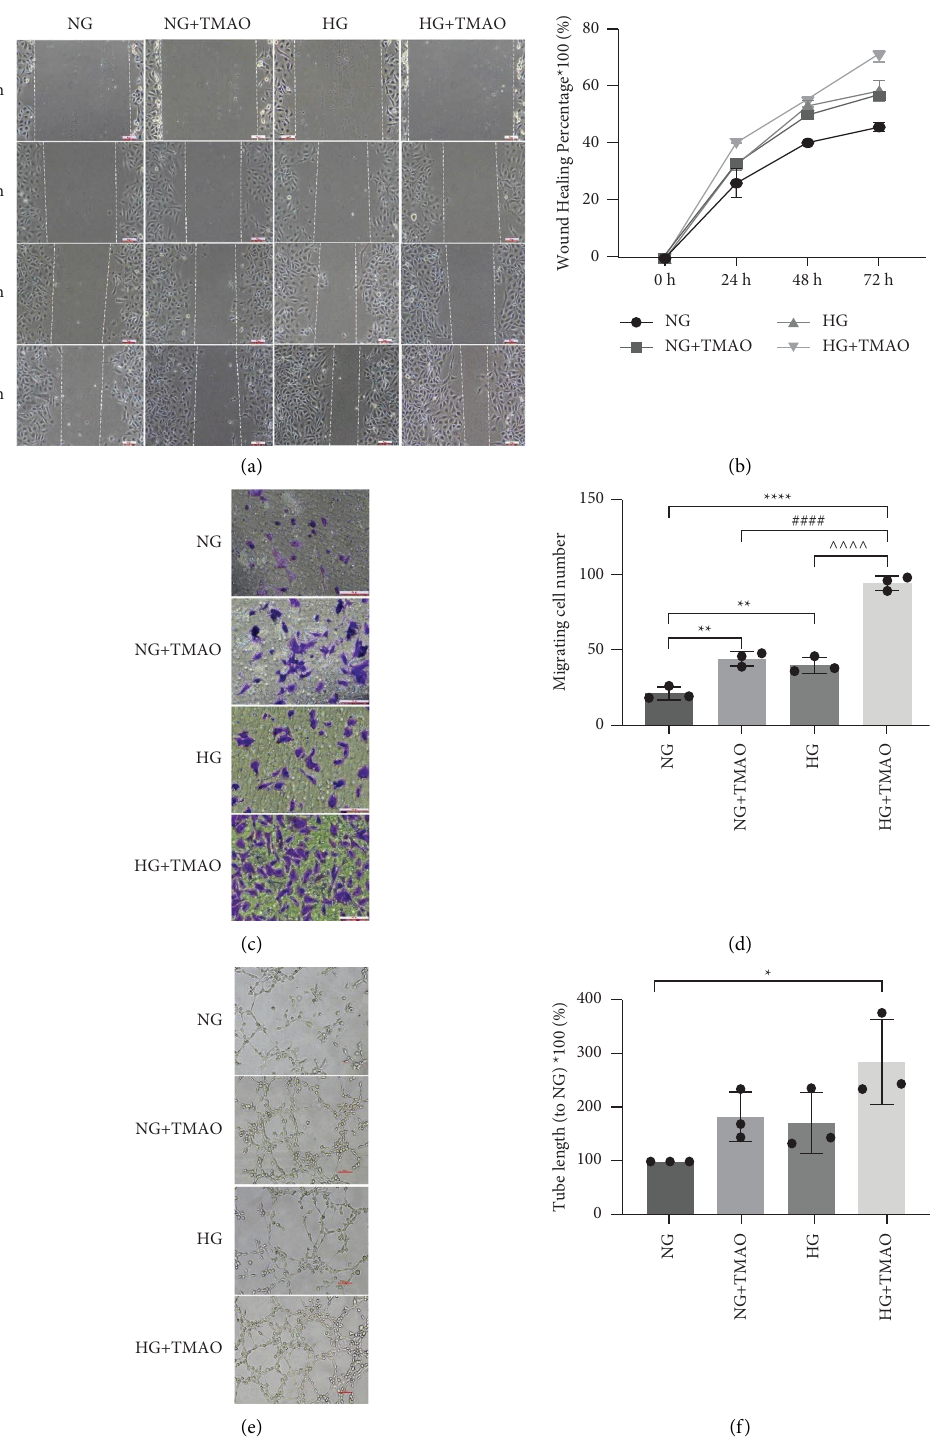
Figure 3: TMAO enhances high-glucose induced wound healing, migration and vascular tube formation of human retinal microvascular endothelial cells. In the wound healing assay, TMAO accelerated the healing process induced by high glucose as shown in the images. (a) Scale, 100 μ m. Quantitative analysis of wound healing percentage. (b) Cell migration was determined using a transwell assay after cells were treated for 72 h. (c) Scale, 100 μ m. Number of migrated cells. (d) After diferent treatments for 72h, HRMECs were seeded into wells coated with matrigel for 6h, and tube formation was observed. (e) Scale, 50 μ m. Tube lengths were compared to NG. (f) ∗ P < 0 . 05 vs. NG; ^ P < 0 . 05 vs. HG; # P < 0 . 05 vs. NG+TMAO, n �